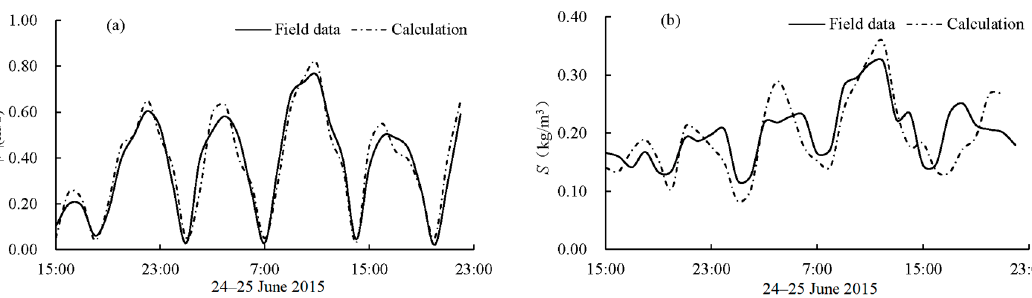
Figure 12. Model validation, numerical results vs. field data at FS2 (neap tide, June 2015): ( a ) |𝑉| ; ( b ) S .